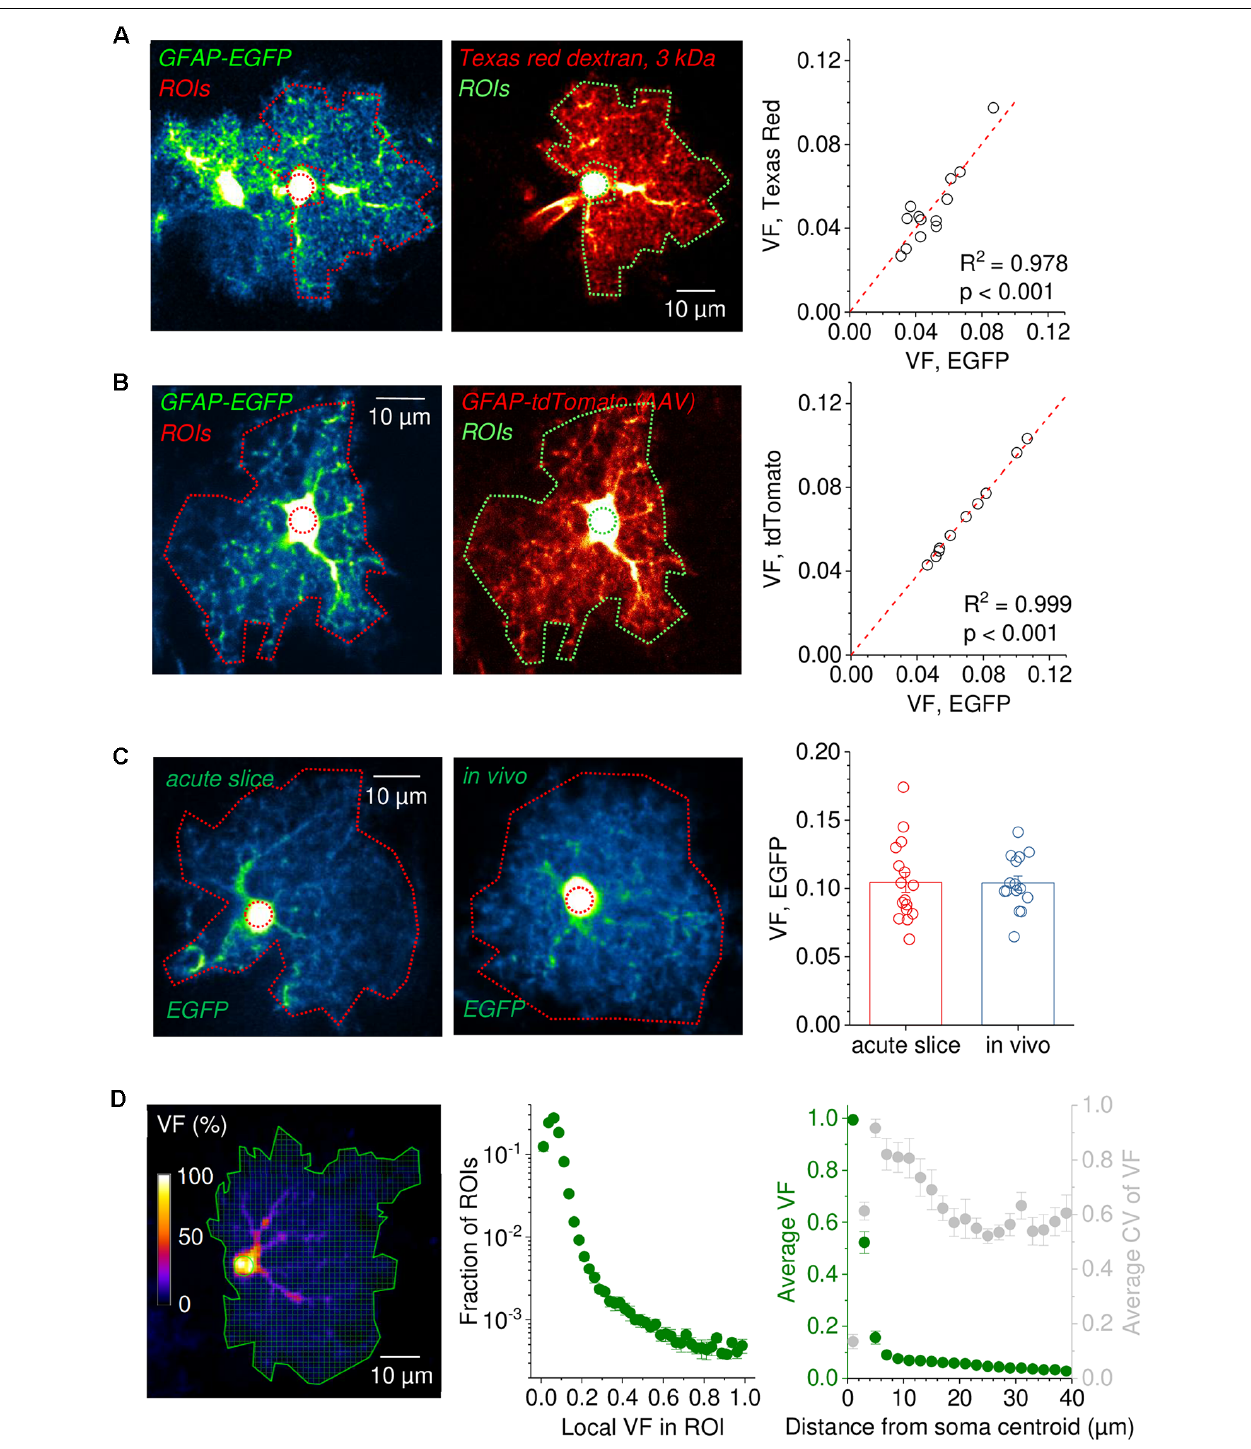
FIGURE 3 | Robustness of astrocytic volume fraction (VF) measurements across experimental conditions. (A) Example of an EGFP-expressing astrocyte before (left panel) and after patching and filling with the gap junction impermeable dye Texas Red dextran 3 kDa for 20 min (middle panel, patch pipette visible left of the soma). Note the similar appearance of the patched cell and the previous EGFP fluorescence). The somatic reference regions of interest (ROIs) are illustrated by a circular dotted line. ROIs for analysis sparing the soma and perisomatic region are also delineated by dotted lines. Pseudo color images for revealing low-intensity details. Right panel: Comparison of volume fractions (VF) obtained by normalizing the average fluorescence in the analysis ROI to that in the somatic reference ROI.